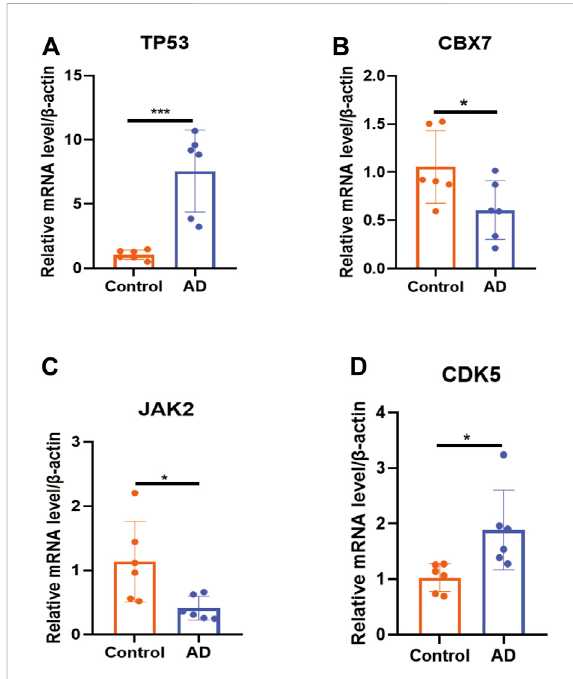
FIGURE 6 Validation of expression of each DECR by RT-qPCR. (A – D) Expression of DECRs (TP53, CBX7, JAK2, and CDK5) between samples from healthy controls and AD patients ( n = 6 per